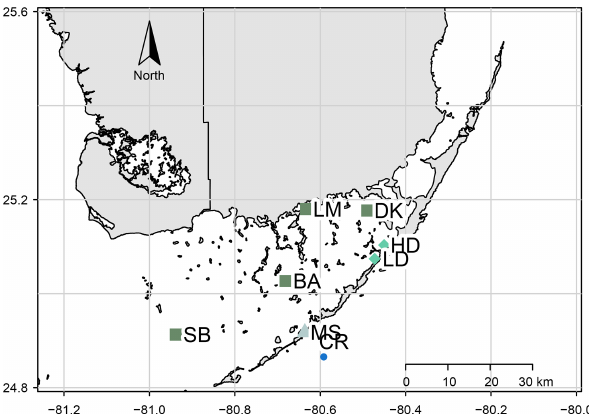
Figure 1. Site map, showing locations of the high- and low-density sites (HD and LD) and meteorological stations used to derive U 10 and p CO 2 data (MS and CR, respectively). Additional FCE-LTER sites used in this study are shown as the dark-green squares: Sprig- ger Bank (SB), Bob Allen (BA), Little Madeira (LM), and Duck Key